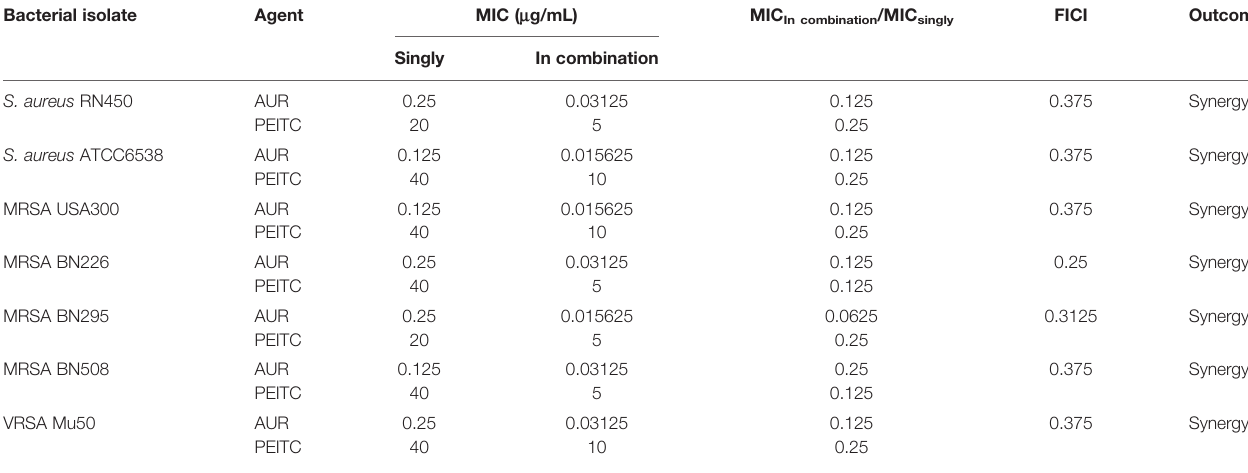
TABLE 1 | The antimicrobial susceptibility and combined effects of AUR and PEITC alone or in combination against S. aureus strains. Bacterial